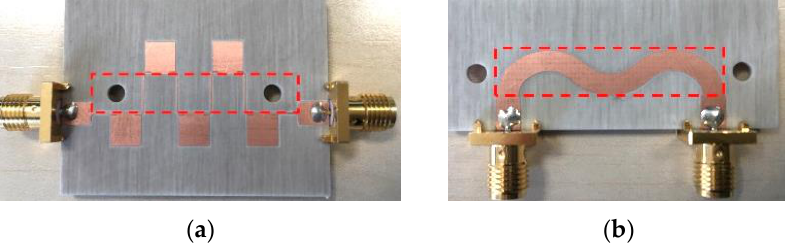
Figure 6. Photograph of the fabricated sensors. ( a ) Capacitively-loaded line sensor; ( b ) meander line sensor. Dimensions (in mm) are: l C = 5.0, l acc = 0.2, W acc = 3.0, l h,1 = 3.19, l h,2 = 5.35, and W h = 0.23 [in reference to Figure 5a]. Reprinted with permission from [61].